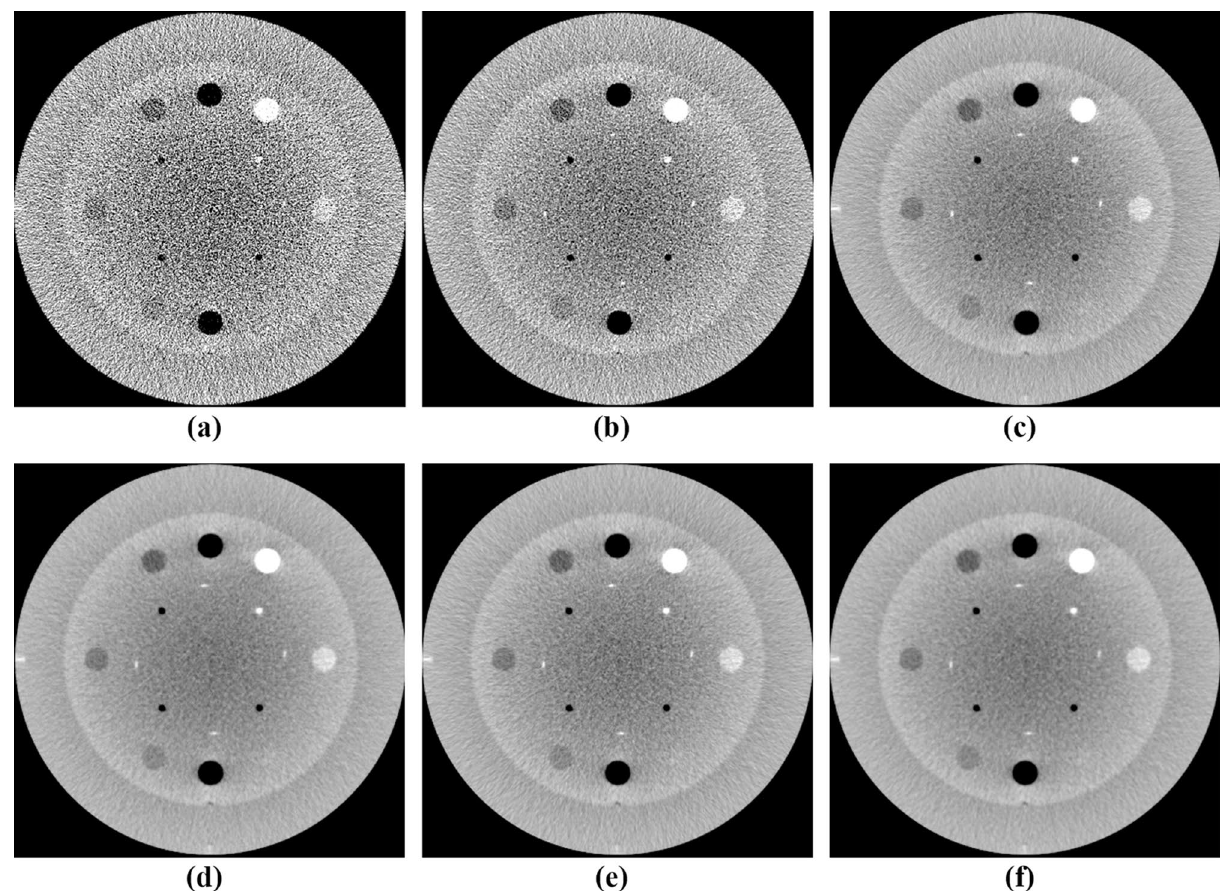
Figure 5. Comparison between the same views of the high resolution reconstruction image generated by applying FDK with ( a ) SL, ( b ) ATV, ( c ) NLTV, ( d ) SL + cubic B-spline, ( e ) ATV + cubic B-spline, and ( f ) NLTV + cubic B-spline using the Catphan503 phantom. These images are displayed at window (width and level) settings of (975, 0)